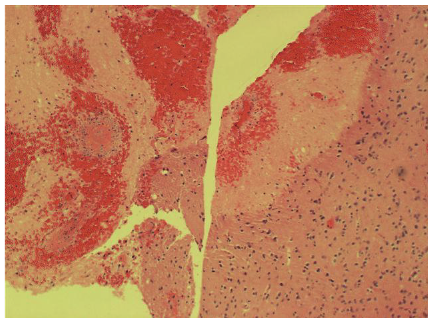
Figure2:Thestarkcontrastbetweennormalbraintissuetotheright (having few inflammatory cells) and the necrotic hemorrhagic tissue to the left.